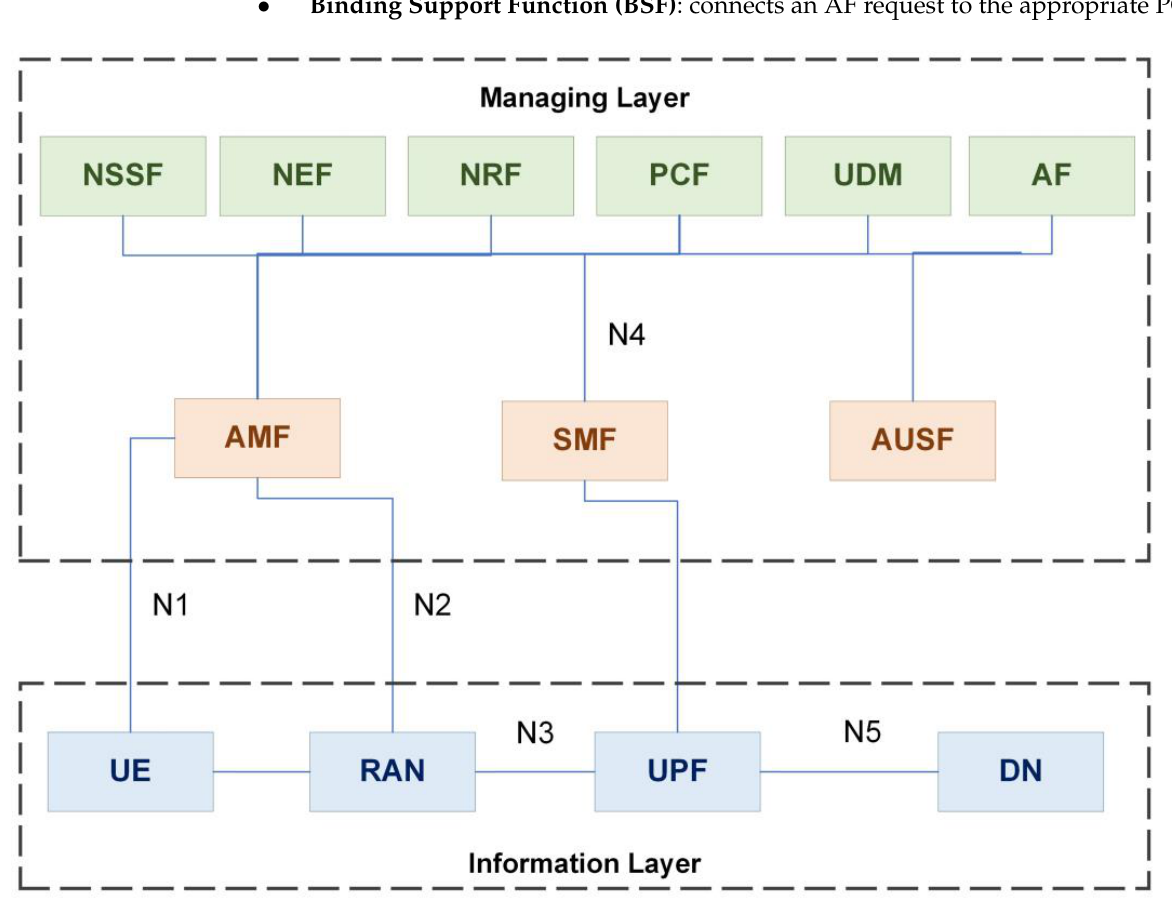
Figure 6. The 5G network core service-based architecture (SBA).